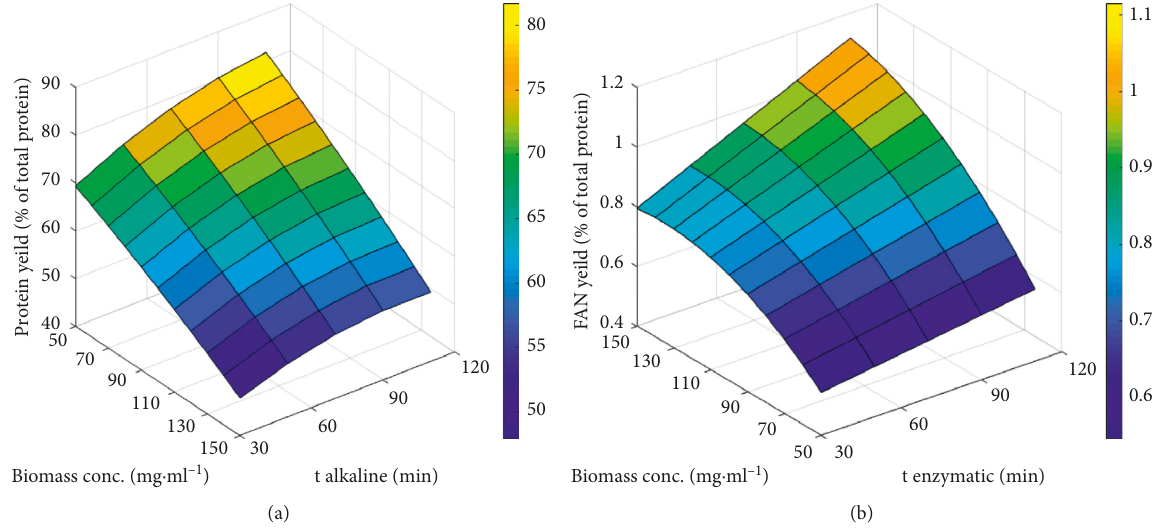
Figure 3: Response surface diagrams showing (a) the effect of the biomass concentration and the time of the alkaline reaction on the protein yield (% of total protein) ( t e � 120min and T e � 60 ° C) and (b) the effect of the biomass concentration and the time of the enzymatic reaction on FAN yield (% of total biomass) ( t a � 120min and T e � 60 ° C).